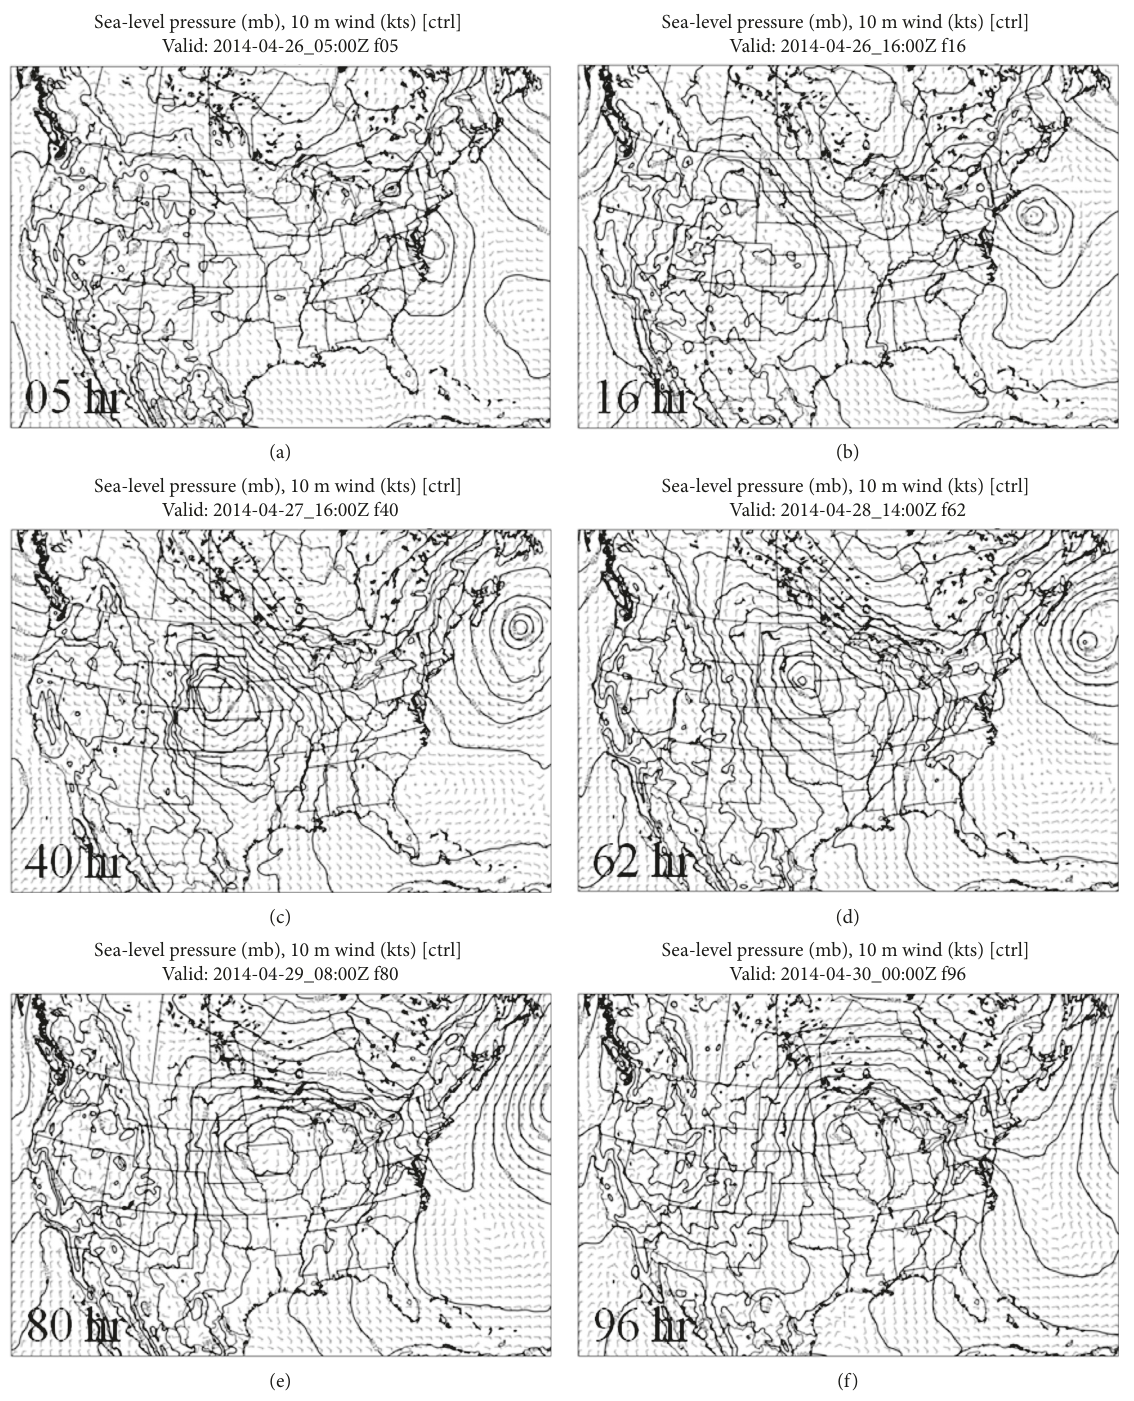
Figure 11: Surface sea-level pressure and 10 m wind speed at forecast hours 05 (a), 16 (b), 40 (c), 62 (d), 80 (e), and 96 (f) for the 26 April 2014 control